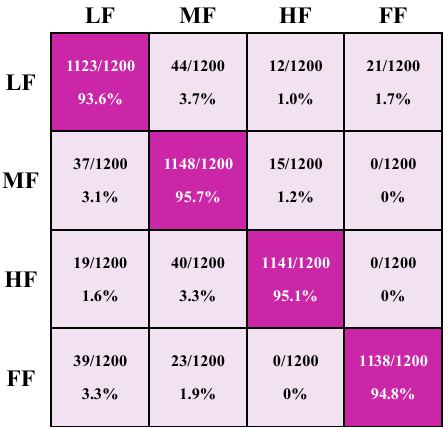
Figure 10. The confusion matrix of the SVM classifier after optimization of secondary meshing pa- rameters.